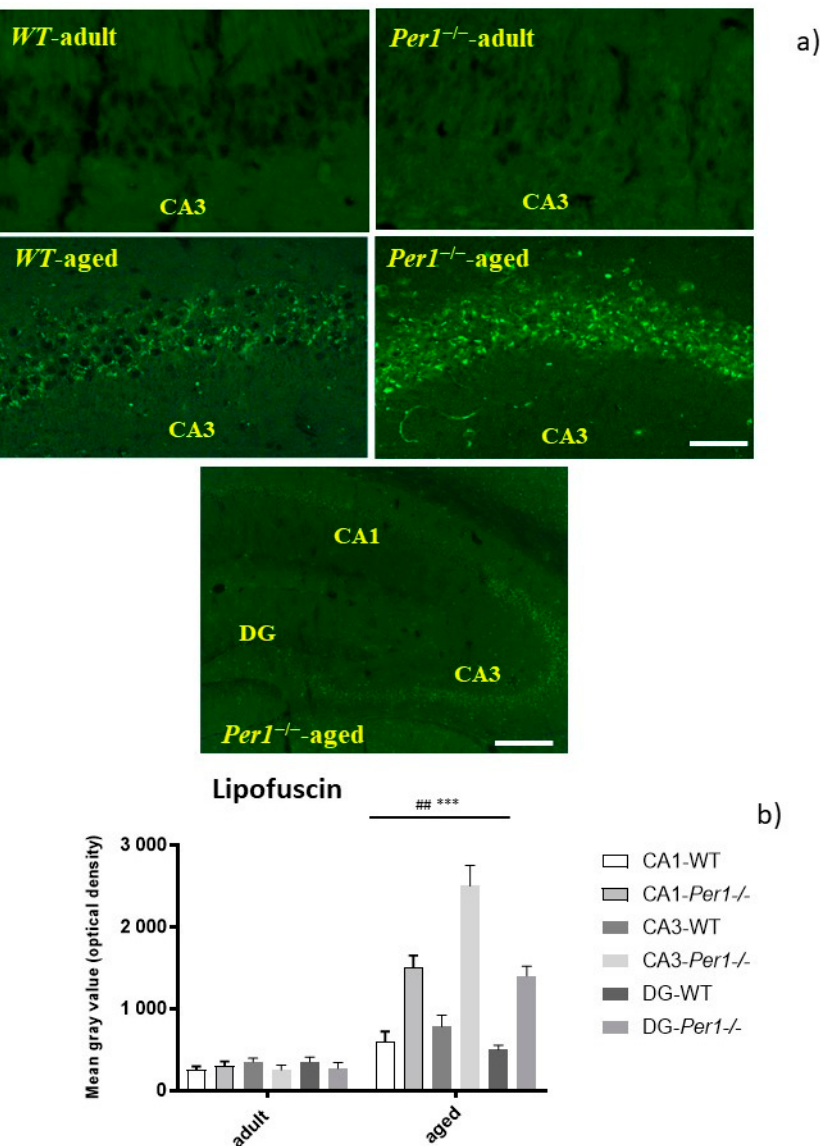
Figure 1. ( a , b ) Increased lipofuscin accumulation in the hippocampus in aged Per1 − / − -mice. ( a ) Representative images of the CA3 region of the hippocampus in young and old wild type and Per1 − / − -mice. Brain slices were stained with DAPI to visualize the nuclei of the cells (blue fluorescence). Lipofuscin accumulation is indicated by the presence of autofluorescence (number of slices evaluated per group = 18). Scale bar: 100 mm. ( b ) Quantification of lipofuscin autofluorescence in the hippocampus in adult and old wild type and Per1 − / − -mice. Columns represent group mean values; error bars represent standard errors of mean (SEM). *** p < 0.001 difference between the age groups; ## p < 0.01 differences between genotypes. The formation of autofluorescent lipopigment or lipofuscin is a highly consistent and reliable cytological change that correlates with cellular ag- ing in postmitotic cells. Autofluorescent lipofuscin in the hippocampus of aged Per1 − / − -mice is significantly higher than in aged WT mice. Scale bar 200 µ